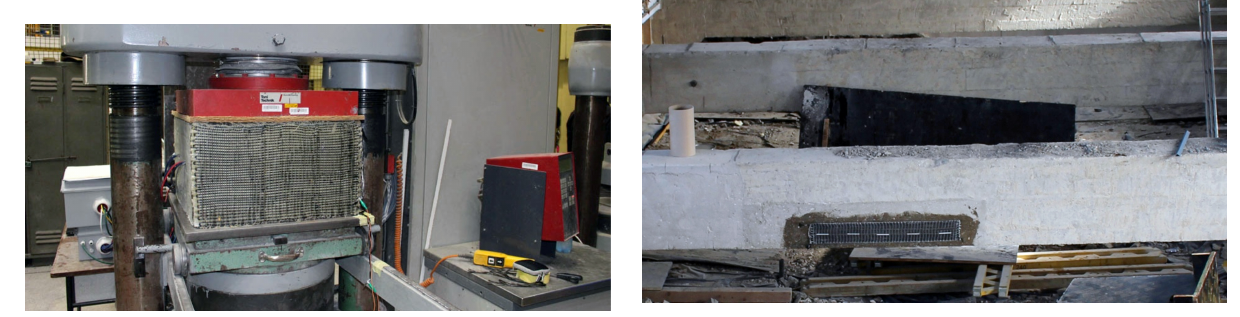
Figure 10: Results of tests on timber beam strengthened with textile sensor.